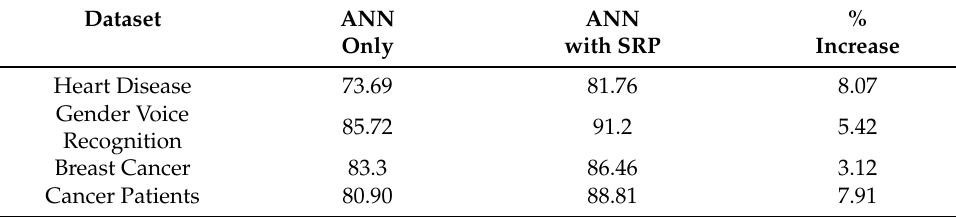
Table 7. Accuracy of datasets with random samples.